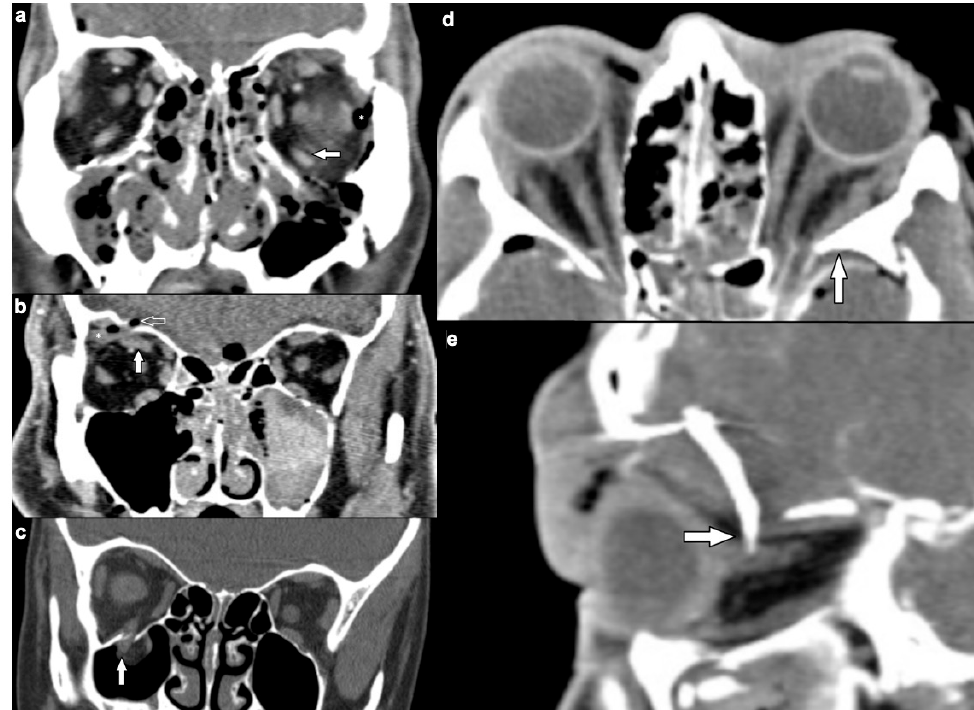
Figure 2. ( a – c ) Dislocated extraocular muscles. CE-MSCT, soft tissue window, coronal reformations. ( a ) Dislocation of the left inferior rectus muscle (white solid arrow) due to orbital floor fracture. Asterisk indicates orbital emphysema. ( b ) Displacement of the right superior rectus muscle (solid white arrow) with orbital roof fracture (white outlined arrow) and intraorbital hemorrhage (asterisk). Concomitant left hematosinus maxillaris due to midface fractures. ( c ) Right inferior rectus muscle (white solid arrow) incarcerated in a so-called “trapdoor fracture” of the orbital floor. ( d , e ) Extraocular muscles pierced by bone fragments. CE-MSCT, soft tissue window. ( a ) Axial reformation. Left lateral rectus muscle pierced by a fragment of the greater sphenoid wing (white arrow). ( b ) Sagittal reformation. Right superior rectus muscle pierced by a frontal bone fragment (white arrow), which also displaces the optic nerve (CE-MSCT = contrast-enhanced multi-slice